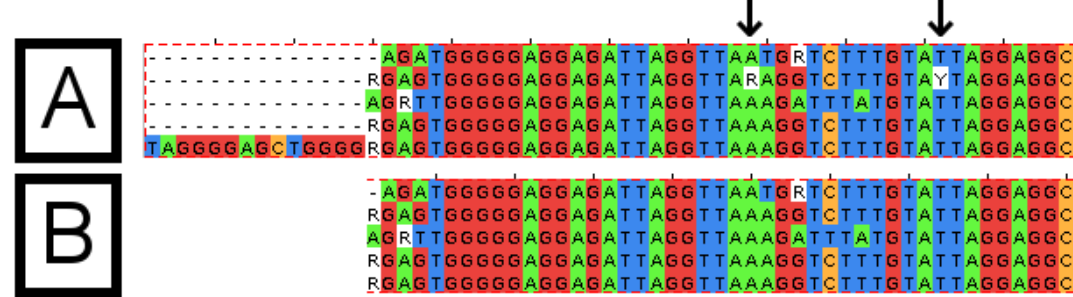
Figure 4. Sequence alignments before and after processing by the Automatic Alignment Clean-Up Tool (AACT). The sequence alignment, which was provided as input to the "AACT" tool ( A ) and the alignment produced by the tool ( B ). Columns containing at least 80% gaps (top, left of image) have been removed. Columns containing only one base type, with an ambiguous base, have been disambiguated (arrows). Columns containing a variety of bases are not altered. The alignments were visualized using the “JalView”